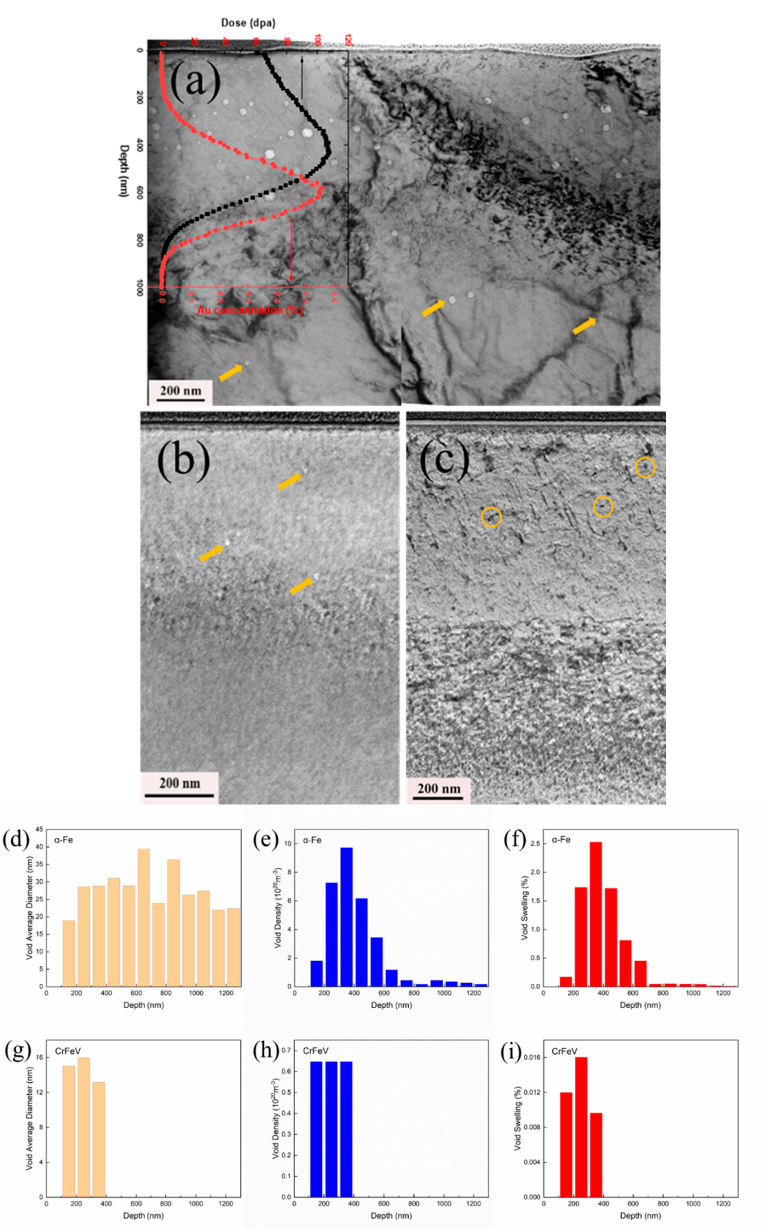
Figure 3. BF TEM images of: ( a ) α -Fe (the yellow arrows show some voids beyond Au ions range); ( b ) CrFeV (the yellow arrows indicate voids for clarity); and ( c ) AlCrFeV (the yellow circles show some defect clusters in the irradiated region) irradiated by 6 MeV Au ions at a fluence of 1.5 × 10 16 cm − 2 at 500 ◦ C. ( d – f ) Void average diameter, void density, and void swelling at various depths in α -Fe and ( g – i ) in